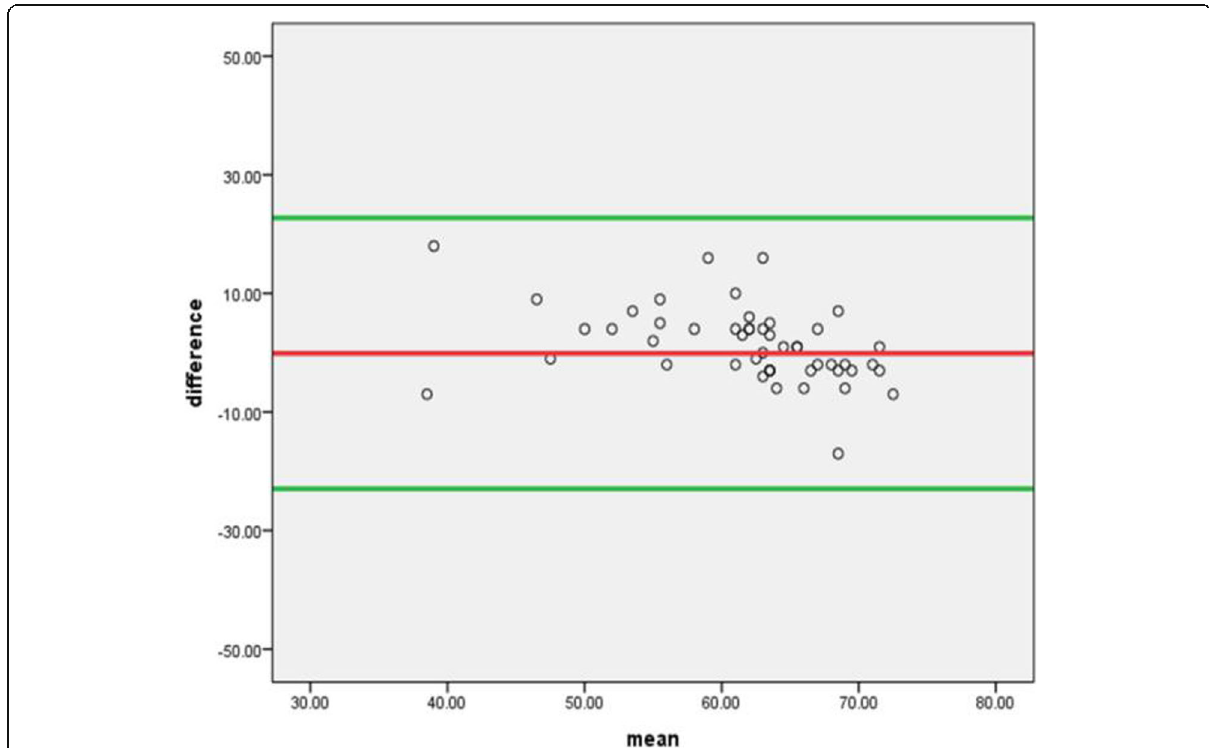
Fig. 4 Bland-Altman plot of LVEF shows the difference between EF by MDCT and 2D echocardiography plotted against the average value of them (solid red line, mean value of difference; green line, mean value of differences ± 2 SDs) a mean value of difference (±SD) of 0.8 ± 11.6% ( p < 0.05) between MDCT and 2Dechocardiography. The 95% limits of agreement ranged from − 3.3 to 3.2%